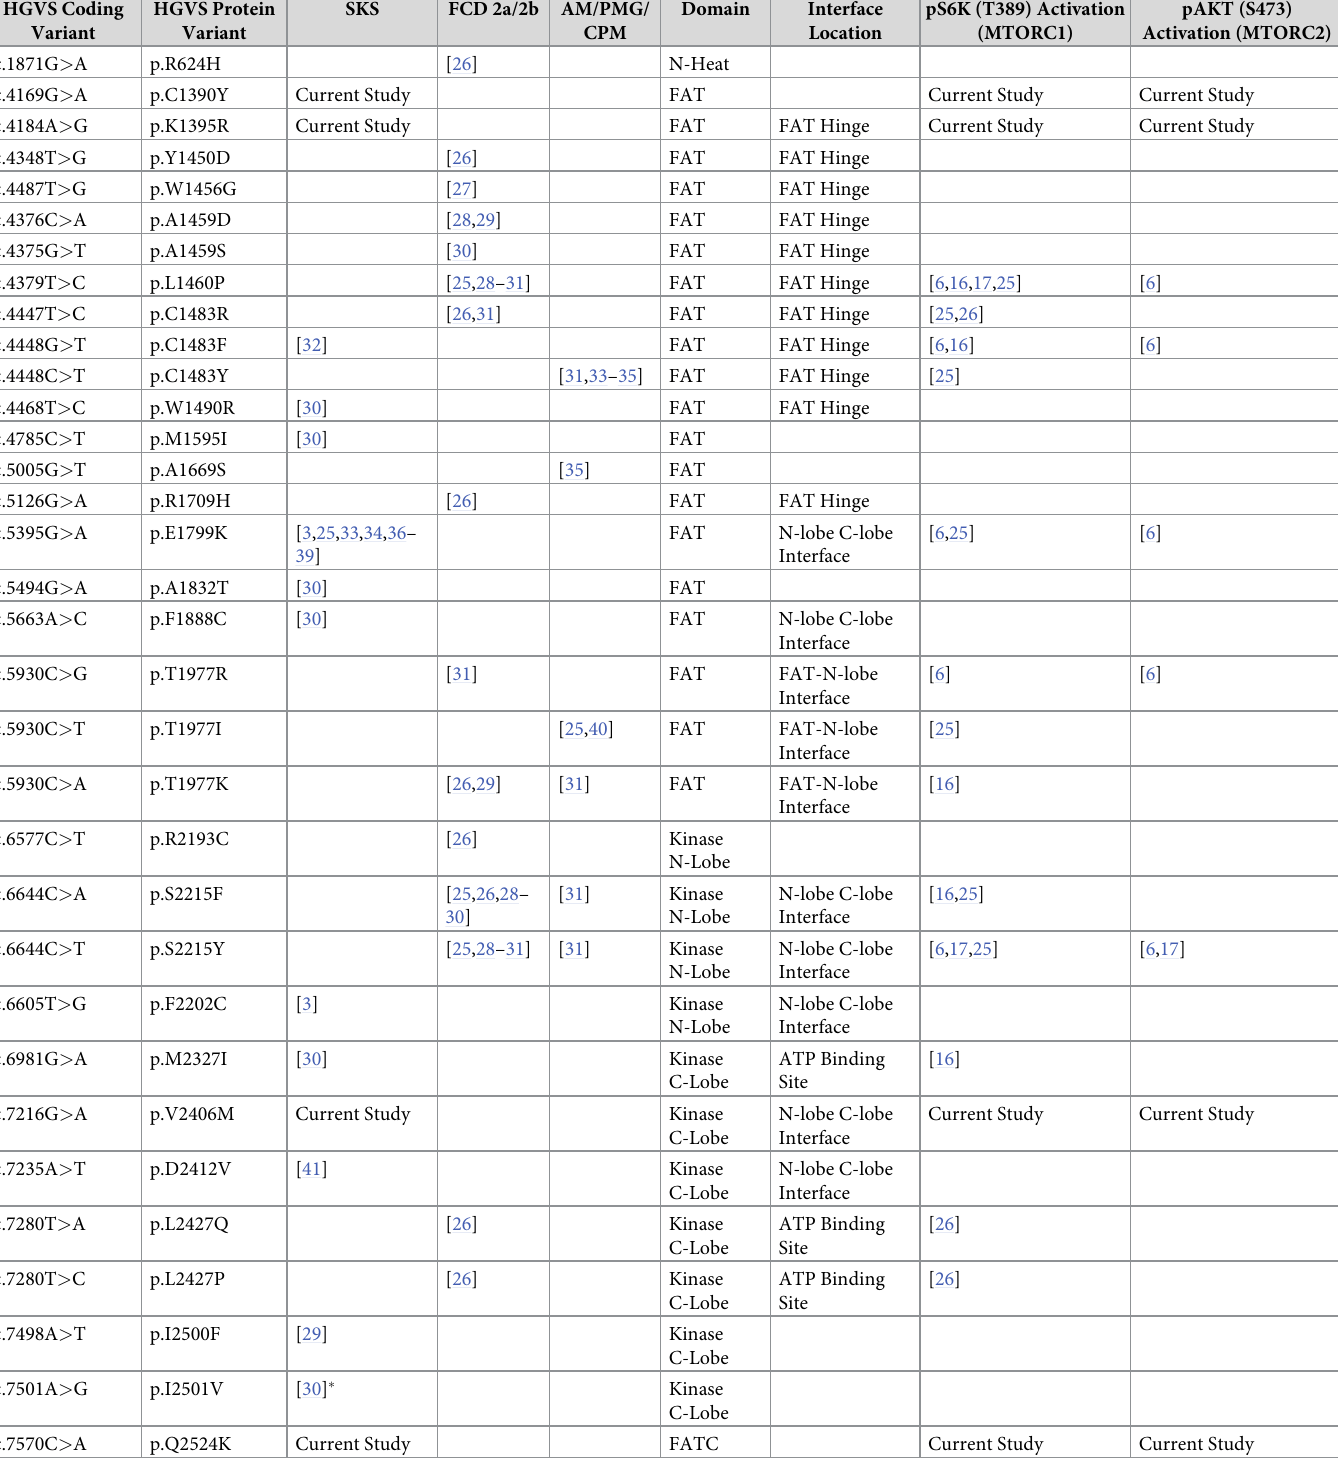
Table 2. Summary of NDD-associated MTOR